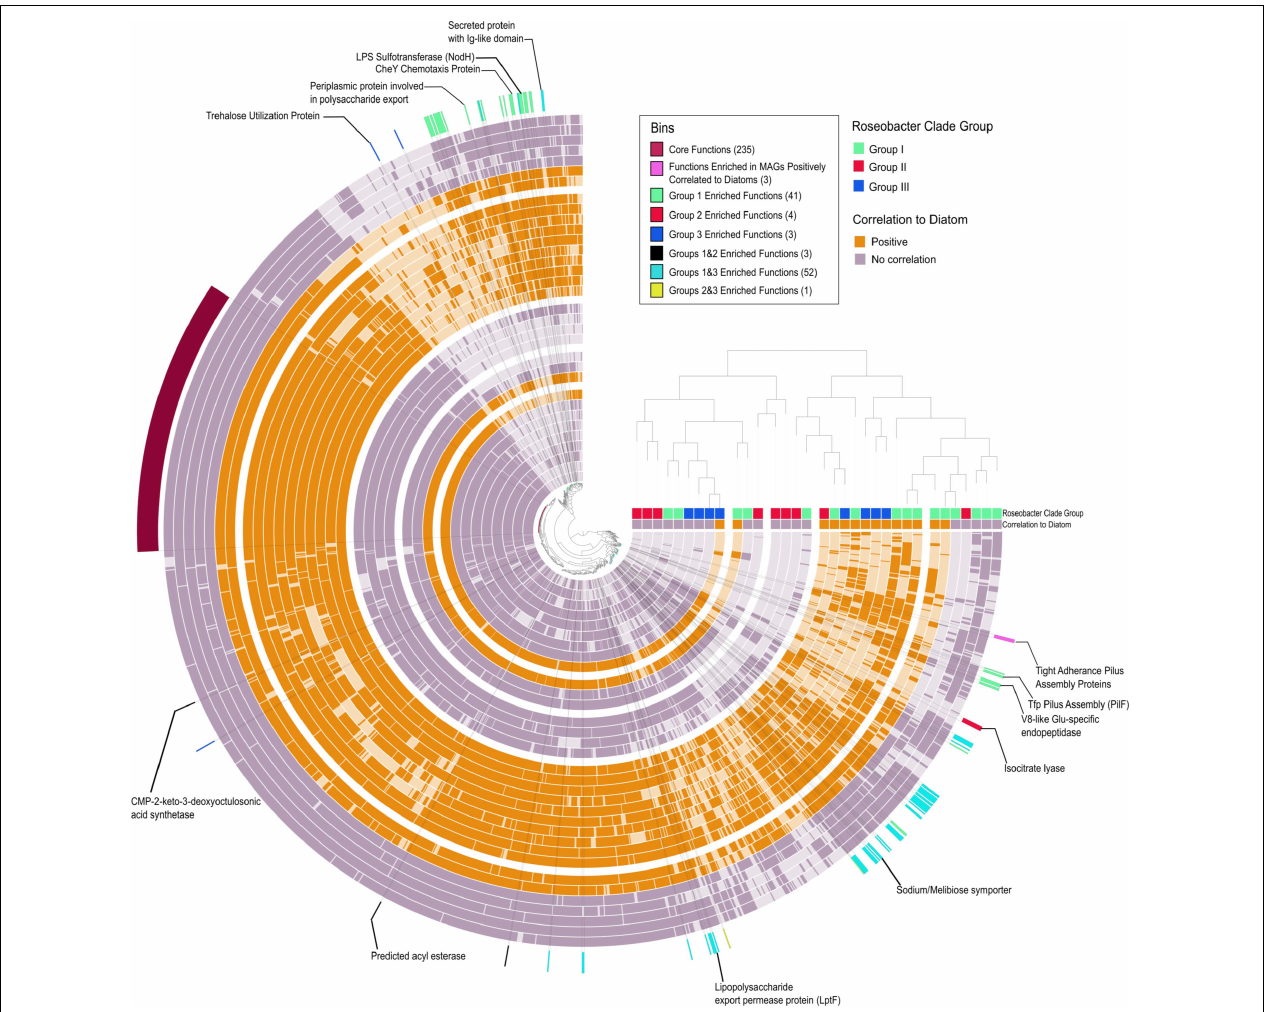
FIGURE 6 | Pangenomic and enrichment analysis of Rhodobacterales MAGs. Concentric circles represent individual MAGs with dark shading indicating the presence of a COG and light shading indicating absence of a COG. The central tree is based on COG functional occurrence in a MAG and the tree on the right is based on overall functional similarity between the MAGs. Bins indicate functions (COGs) that are significantly enriched in a specific group of MAGs. Functions enriched in MAGs positively correlated to diatoms selected based on the criteria of being present in > 70% putative colonizers and < 20% in putative generalists. Numbers in parenthesis beside the bin name indicated the number of COGs in that bin ( Supplementary Table 6 ). Positively correlated MAGs are considered putative phycosphere colonizers and non-correlated MAGs are considered putative